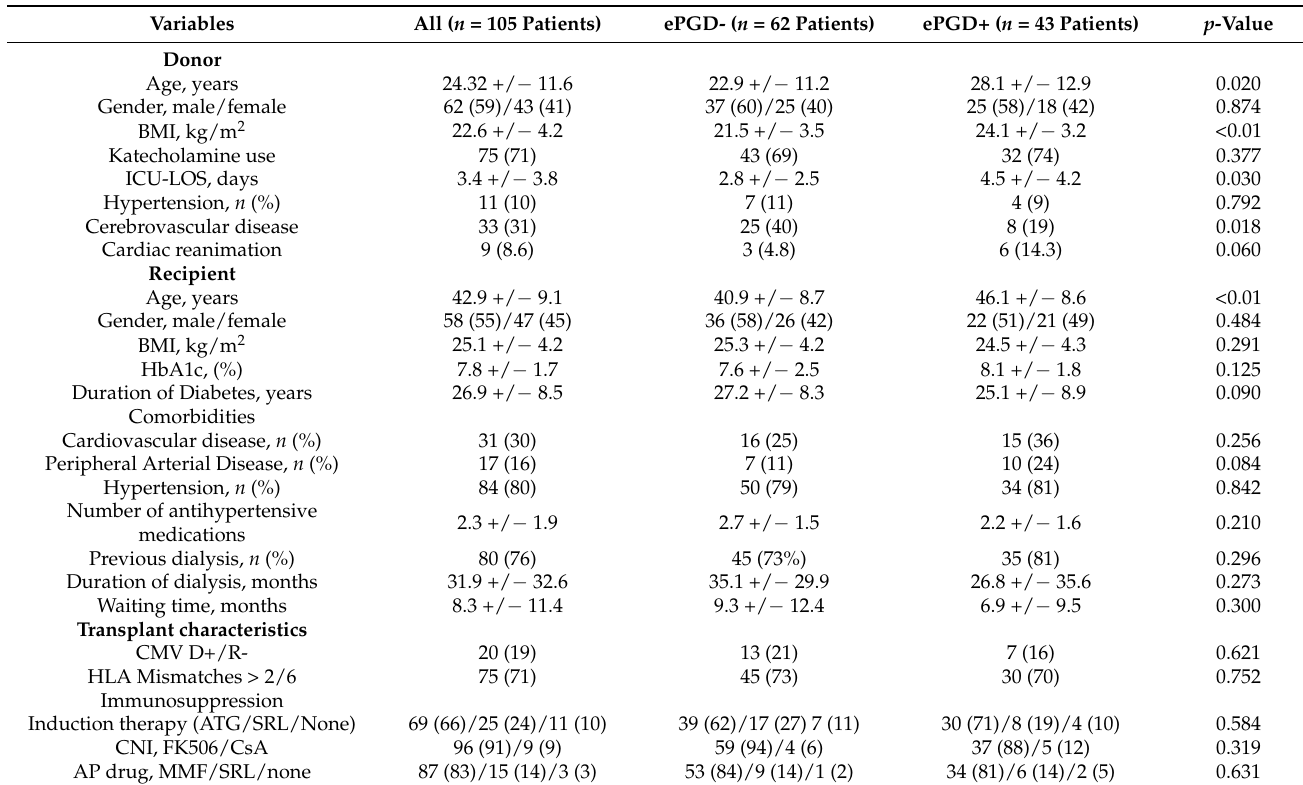
Table 1. Baseline perioperative transplant characteristics of recipients and donors according to the status of early pancreatic graft dysfunction (ePGD).